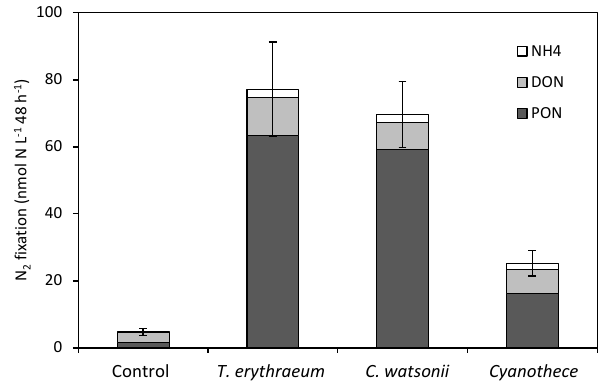
Figure 3. N 2 fixation rates (dark grey, nmolL − 1 48h − 1 ), DDN re- lease (nmolL − 1 48h − 1 ) as DON (light grey) and NH + each treatment. Error bars represent the standard deviation of tripli- cate incubations and the propagated analytical